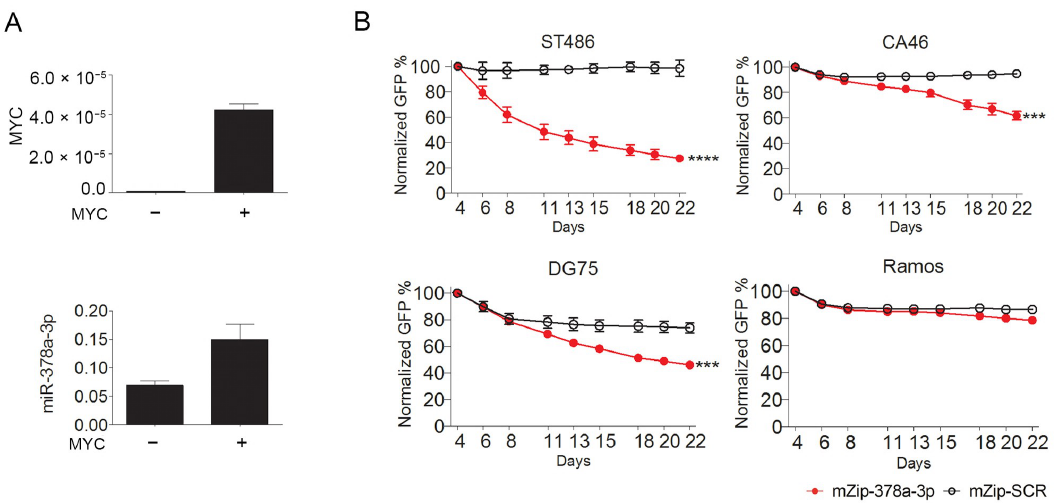
Figure 2. MYC-induced miR-378a-3p is essential for BL cell growth. ( A ) Levels of MYC and miR-378a-3p in tetracycline treated (“ − ”, MYC-o ff ) and non-treated (“ + ”, MYC-on) P493-6 B-cells. MYC levels were normalized to RNA Polymerase II Subunit A (POLR2A). MiRNA levels were normalized to SNORD44. ( B ) Green fluorescent protein (GFP) growth competition assay upon miR-378a-3p inhibition in four Burkitt lymphoma (BL) cell lines. The miR-378a inhibitor (mZip-378a-3p) and the scrambled control (mZip-SCR) were stably transduced in BL cells using a lentiviral vector, which co-expresses GFP. The GFP percentage was measured for 18 days, and the GFP percentage at the first day of measurement (day 4) was set to 100%. All assays were performed in triplicate. Significant di ff erences were calculated using a mixed model analysis. *** p < 0.001 and **** p < 0.0001.